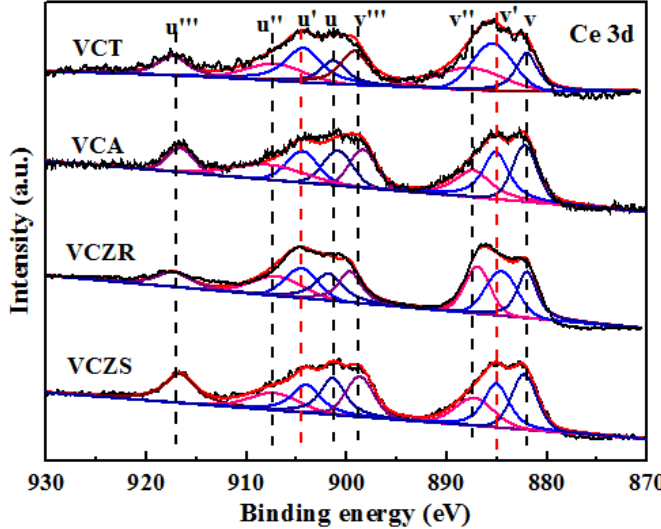
Figure 4. Ce 3d XPS high-resolution scans spectra of different samples.